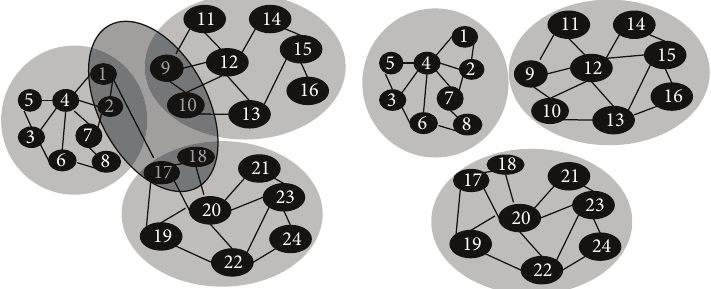
Figure 5: Examples of topology changes.